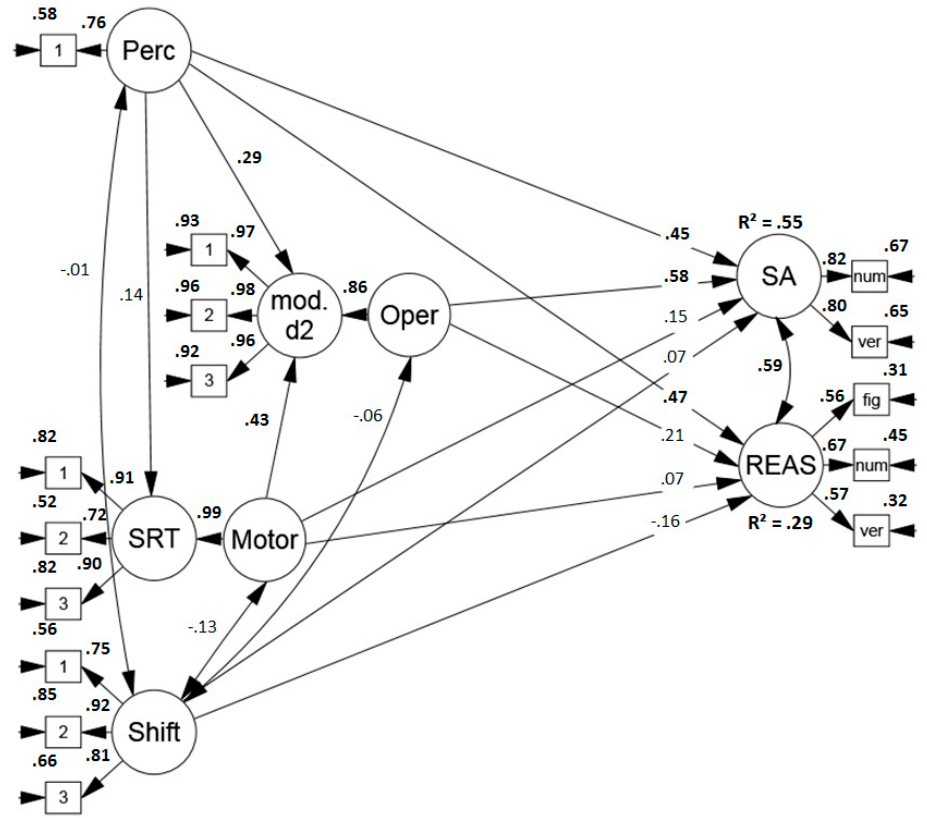
Figure 7. Standardized solution of the model predicting performance in sustained attention tests (convergent validity, without the d2-R as dependent variable) and performance in reasoning tests (discriminant validity). Significant results are printed in boldface. Perc = perceptual speed, mod. d2 = modified d2, Oper = operation speed, SRT = simple reaction time task, Motor = motor speed, Shift = item shifting speed, SA = sustained attention, REAS = reasoning, fig = figural task, num = numerical task, verb = verbal task.